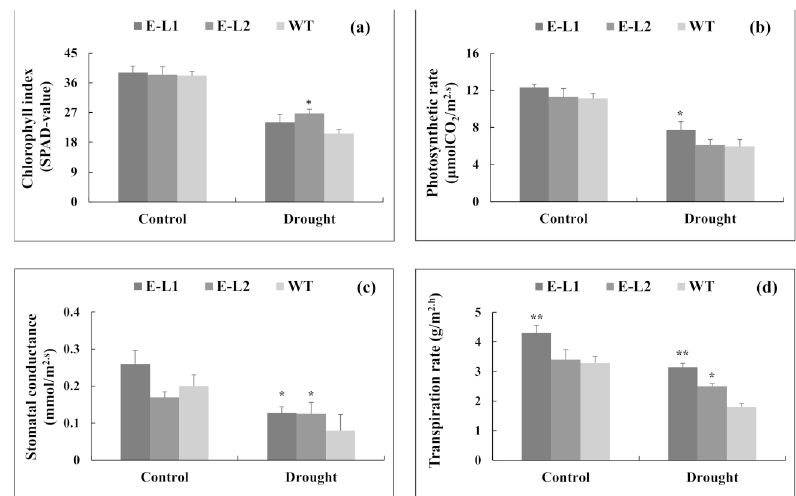
Figure 10. Chlorophyll index (SPAD-value) and photosynthetic parameters of TgERF1 transgenic tobacco and WT in response to drought stress. Plants were grown in individual pots and were watered with one-fifth-strength Hoagland solution and weighed daily during the experiment. Well-watered control plants were grown in 100% field capacity (0% of water loss). The time-course drought stress assay started by withholding the nutrient solution until reaching 70% water loss. The ( a ) chlorophyll index, ( b ) transpiration rate, ( c ) stomatal conductance, and ( d ) photosynthetic rates were measured in leaves of transgenic plants and WT plants under well-watered and water-deficit conditions. Data are presented as the means ± SEM of four biological replicates. Significant differences were determined by ANOVA followed by Dunnett’s test. ** Significant at p < 0.01 and * at p <